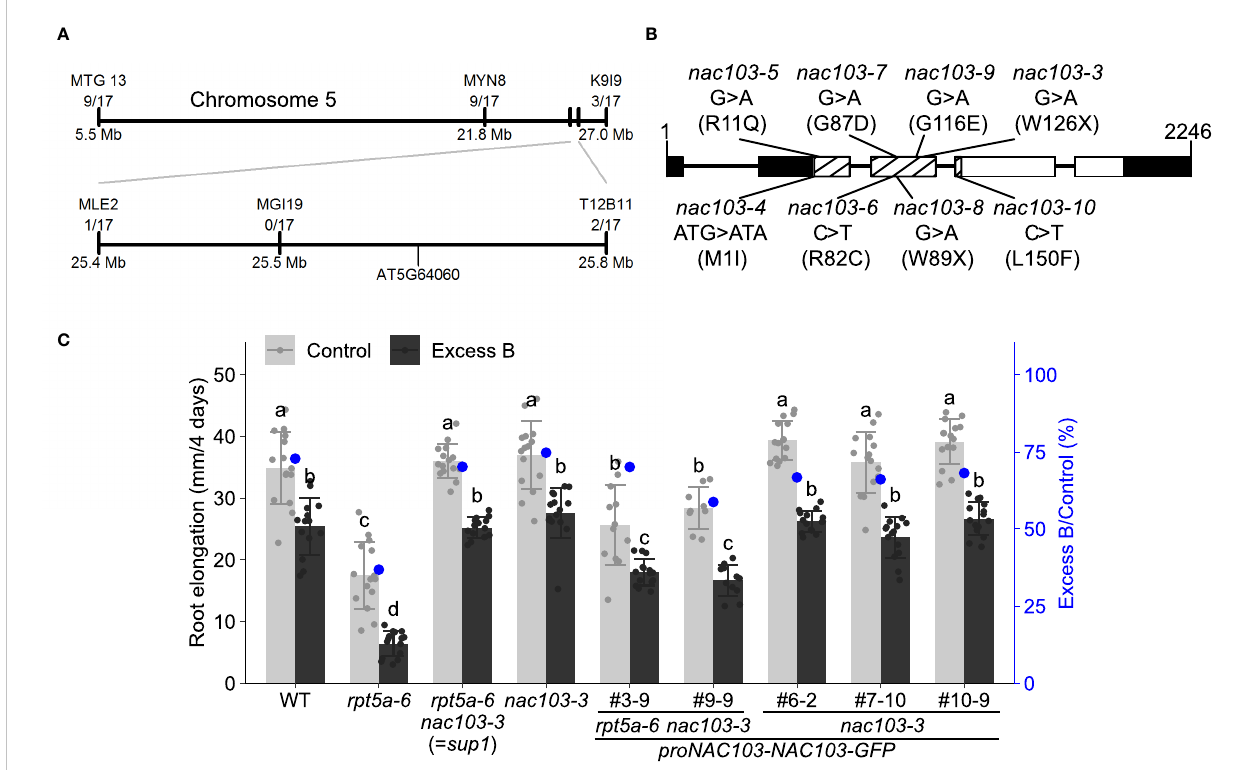
FIGURE 2 Positional identi fi cation of the mutation responsible for suppression of excess boron sensitivity in rpt5a-6 sup1 . (A) Schematic diagram for candidate region in chromosome 5. Molecular markers and the number of recombinant plants found in the mapping population are shown. (B) Schematic diagram of NAC103 gene and point mutations in suppressor lines. For each suppressor line, the line names, nucleotide changes and amino acid changes (parenthesis) are shown. Lines and boxes represent introns and exons respectively. White and black boxes represent cording regions and untranslated regions, respectively. NAC domain is shown by meshing. (C) Root elongation of the complementation lines. Constructs carrying proNAC103-NAC103-GFP was introduced into rpt5a-6 nac103-3 or nac103-3. Seedlings were grown under normal conditions (30 µM boric acid) for eight days and then transferred to excess boron (3 mM boric acid) or control conditions. Root elongation during for four days after the transfer was measured. Numbering with # indicates transformant lines isolated independently. Values are mean ± standard deviation of 9-15 measurements. Groups sharing the same letters are not signi fi cantly different at p < 0.05 by Tukey ’ s